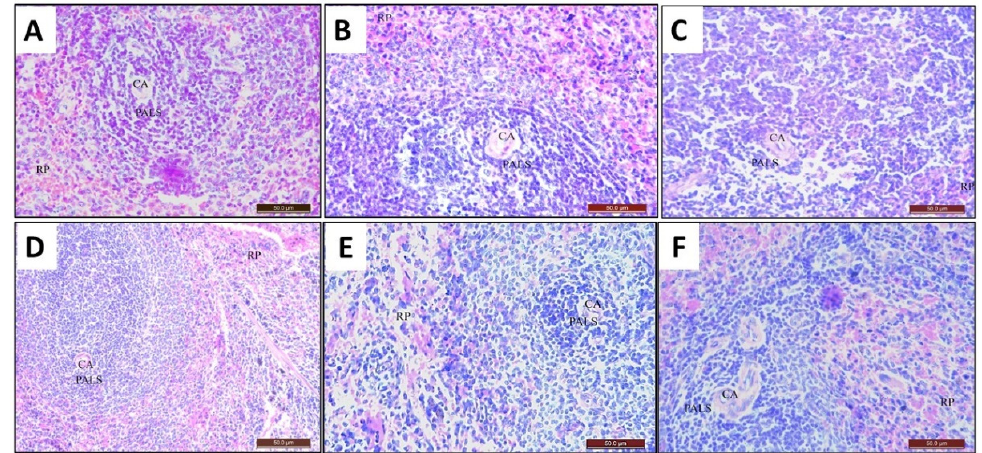
Figure 13. Photomicrographs of section of the spleen stained with H/E ×400 from different groups.